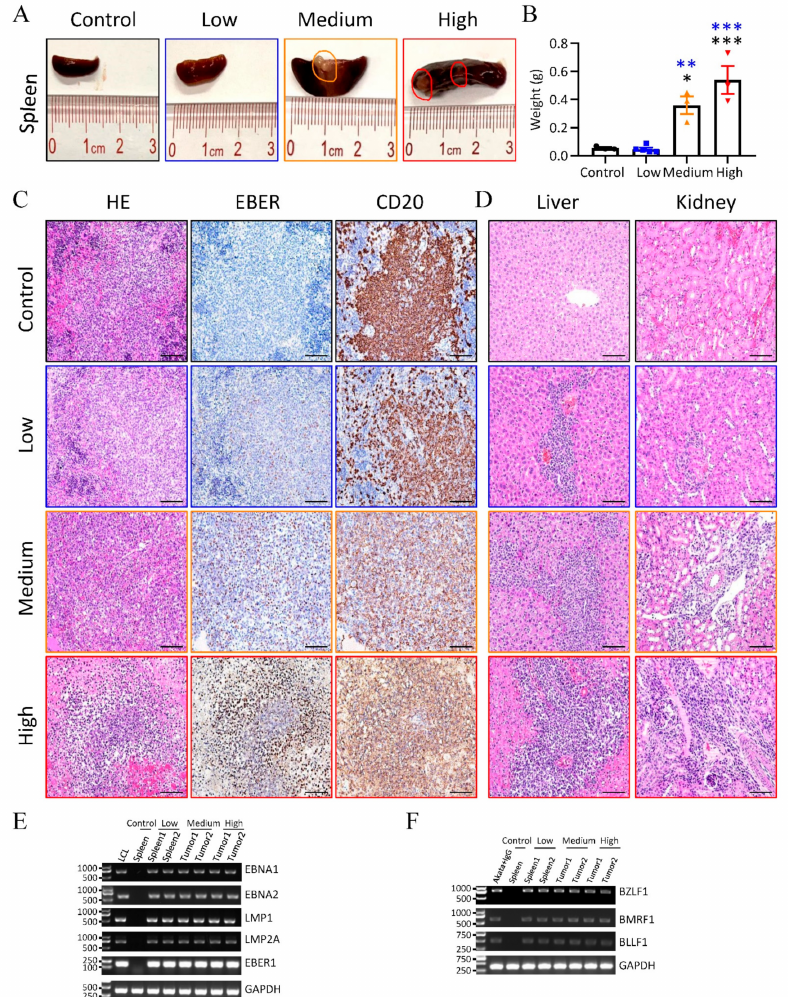
Figure 3. Pathology analyses of EBV-infected humanized mice. ( A ) Representative of macroscopic observation of the spleens from control mice and mice infected with increasing doses of Akata-EBV- GFP. Three mice inoculated with high doses (GRUs) of Akata-EBV-GFP became clinically ill within five weeks, and euthanasia was performed to collect the spleens, livers, and kidneys of mice. Circles indicate site of lesion. ( B ) The mean weight of spleens from ( A ). Data points represent mean ± SEM of uninfected control mice ( n = 3), low ( n = 5), medium ( n = 3), high ( n = 3) doses (GRUs) of Akata-EBV-GFP infected mice. * p < 0.05, ** p < 0.01, *** p < 0.001. ( C ) Splenic sections stained with hematoxylin and eosin (left), hybridized in situ for expression of EBV EBER mRNA (center), and immunostained for the human B lymphocyte marker CD20 (right). Scale bar =50 µ m. ( D ) Liver and kidney sections were stained with hematoxylin and eosin (H&E). Scale bar = 50 µ m. ( E , F ) Reverse-transcription PCR detection of latent ( E ) and lytic ( F ) EBV gene expression in the spleens or tumors from control or EBV-infected humanized mice. Spleens from two different mice inoculated with a low dose (GRUs) of the virus and tumors from two different mice infected with medium or high doses (GRUs) of the virus were examined for expression of EBNA1, EBNA2, LMP1, LMP2A, EBER1, BZLF1, BMRF1, and BLLF1. RNA isolated from the spleens of control mice ( E , F ) used as negative controls, and a lymphoblastoid cell line (LCL) ( E ) and anti-IgG-treated Akata-EBV cells ( F ) were used as positive